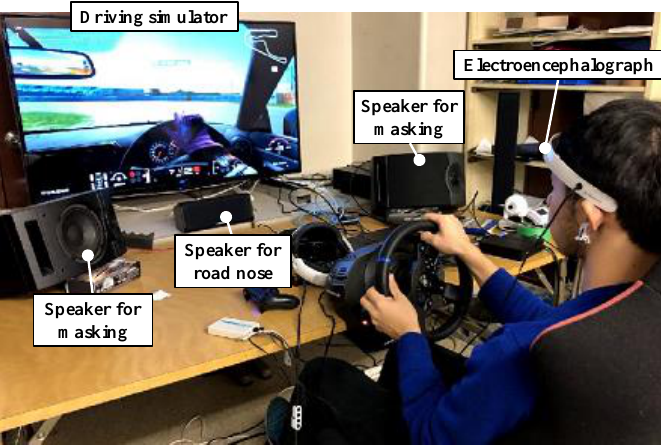
Figure 5. Experimental situation by using driving simulator.